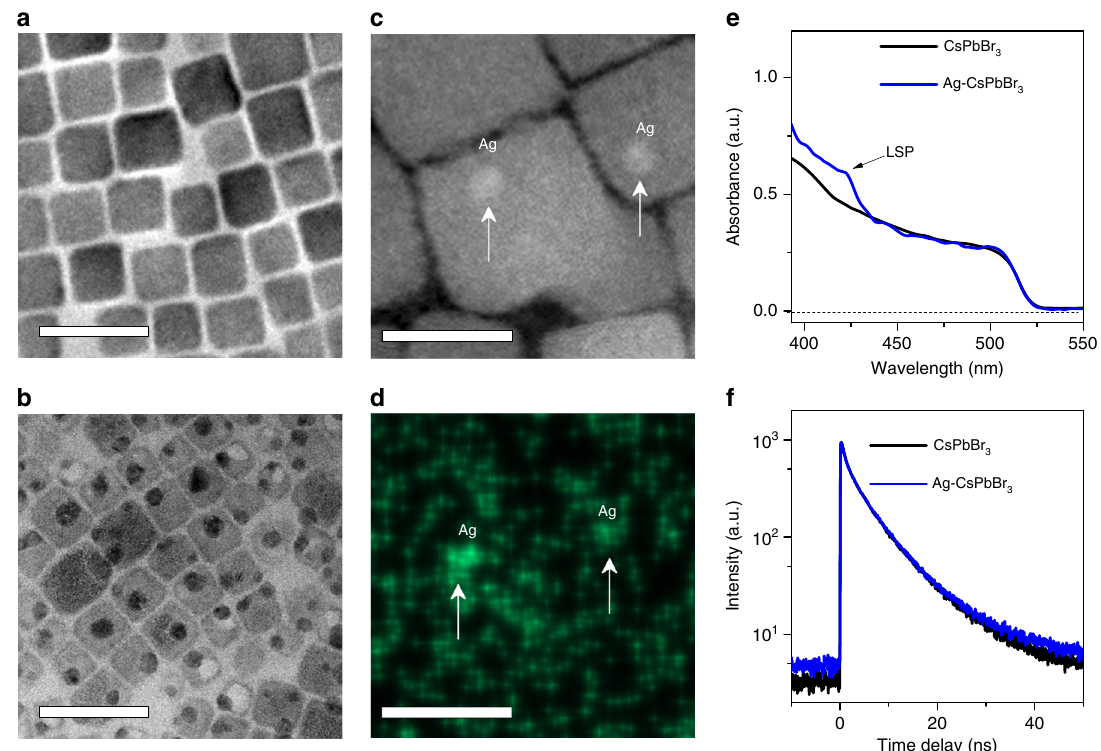
Fig. 2 Characterizations of Ag – CsPbBr 3 nanocrystals (NCs). Typical TEM images of a neat CsPbBr 3 NCs and b Ag – CsPbBr 3 hybrid NCs (scale bar: 20 nm), respectively. c High-angle annular dark- fi eld scanning TEM and d elemental mapping images for element Ag of Ag – CsPbBr 3 NCs at the same spot (scale bar: 10 nm). e Absorption spectra of neat CsPbBr 3 and Ag – CsPbBr 3 hybrid NCs. The absorption peak at ~424nm is attributed to local mode of SPR. f Time- resolved PL traces recorded from neat CsPbBr 3 and Ag – CsPbBr 3 hybrid NCs, hybrid NC samples. Dark dots are observed on the surfaces of cubic CsPbBr 3 NCs, which are the deposited Ag nanoparticles. These dark dots are highly re fl ective in scanning TEM images (Fig. 2c) as expected for the Ag metal, which is further con fi rmed by elemental mapping (Fig. 2d). X-ray photoelectron spectrum (Supplementary Figure 2) con fi rms the formation of Ag nanoparticles. In addition, signals from Ag 2 O or residual AgBr are also observable. Ag 2 O is possibly formed at the surface of Ag